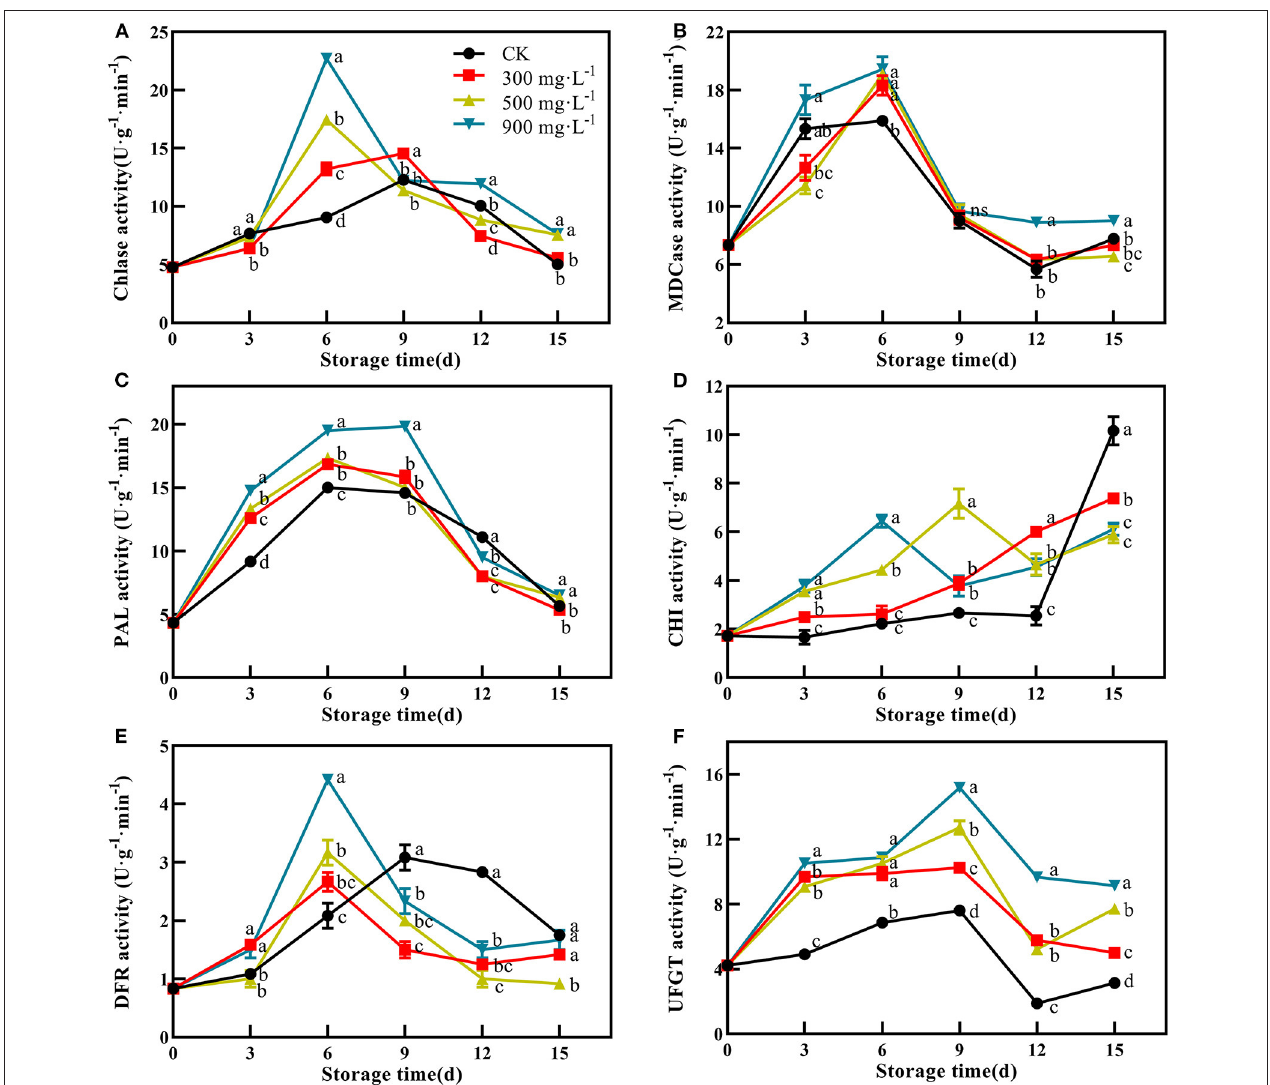
FIGURE 5 | Effects of ETH treatment on activities of Chlase (A) , MDCase (B) , PAL (C) , CHI (D) , DFR (E) , and UFGT (F) . Values followed by different letters are significantly different based on Duncan’s multiple range tests at P < 0.05. The error bars indicate the standard deviations of three biological